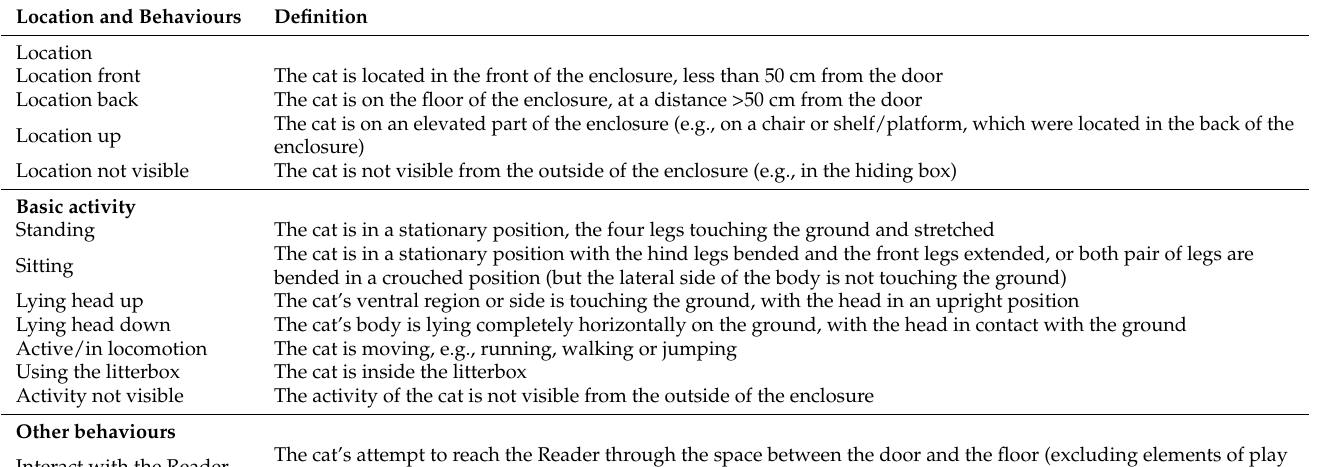
Table 2. Ethogram to record the cats’ behaviour: locations, basic activity and other behaviours. Behaviours were adapted from